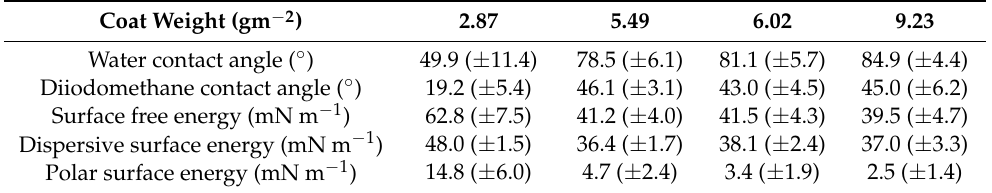
Table 2. Water contact angles, diiodomethane contact angles, and surface free energy and its compo- nents for dry LCNF-modified filters at various coat